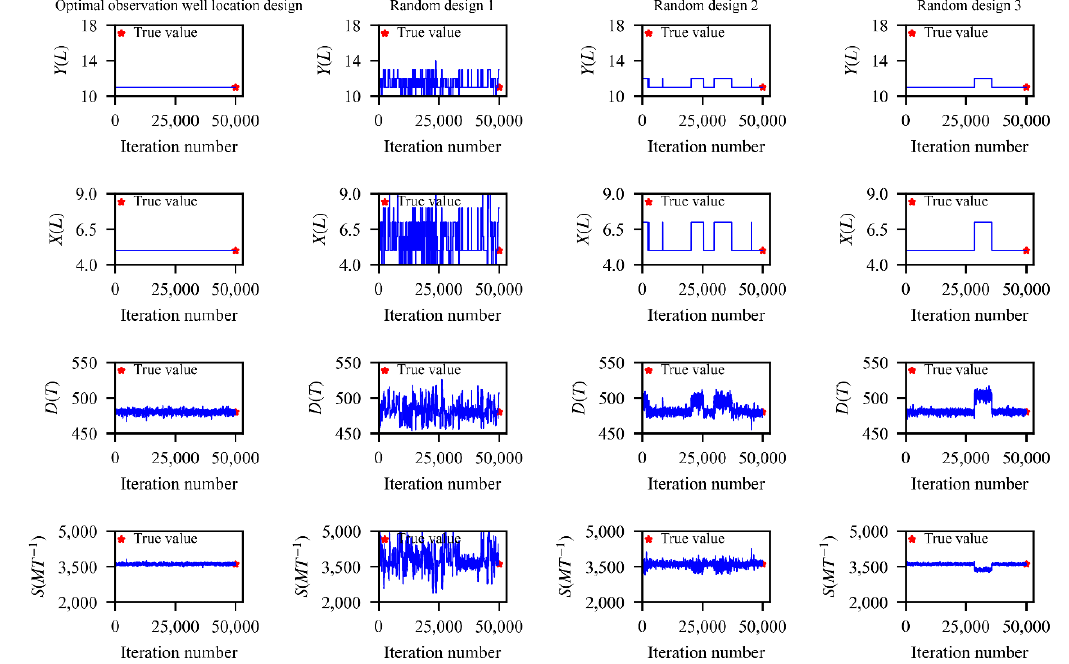
Figure 7. Trace plots of the MCMC simulation for Case 1.